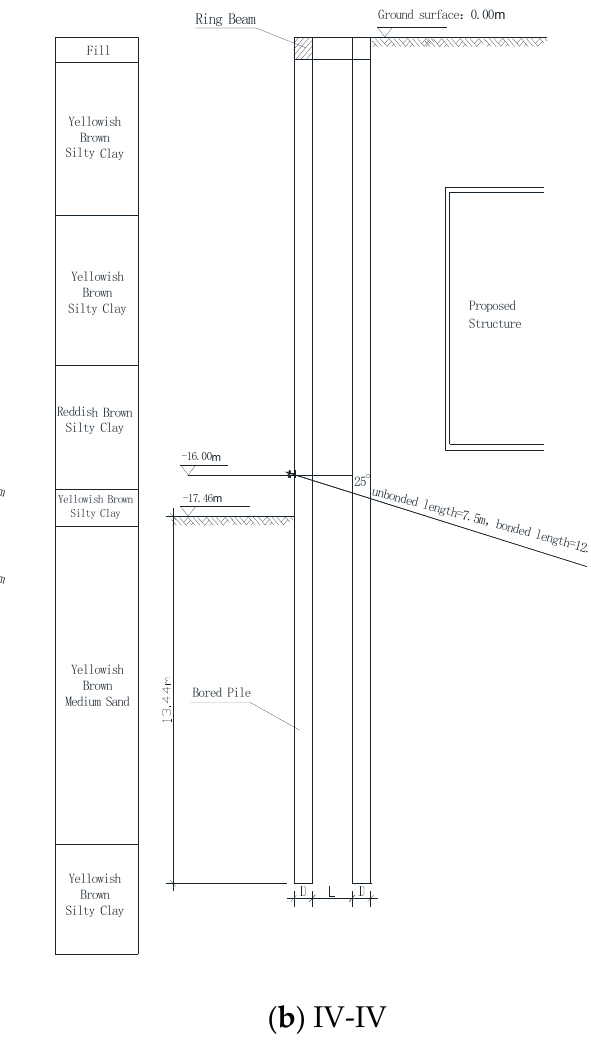
Figure 5. Section of bored-pile wall. Table 1. Construction